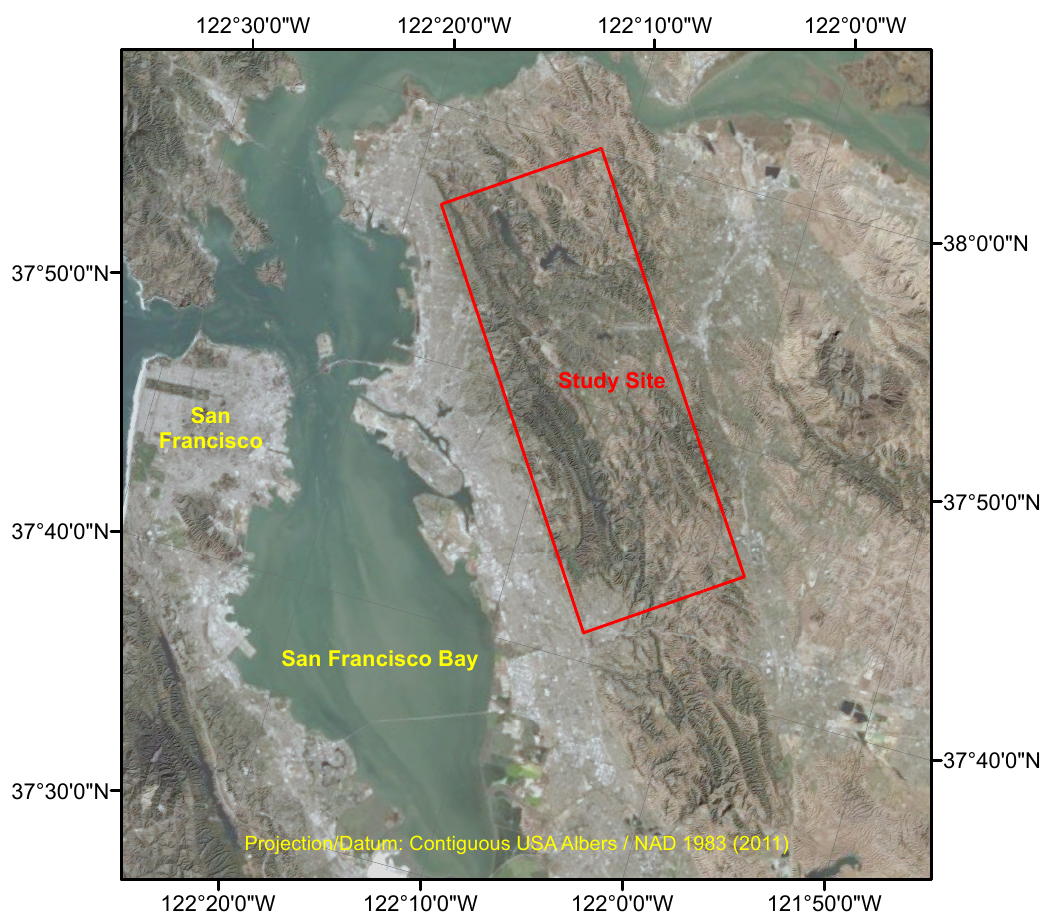
Figure 2. Our study site is located in the East San Francisco Bay Area, covering roughly 235 km 2 of the highly-researched wildland urban interface (WUI) that is at high risk of wildland